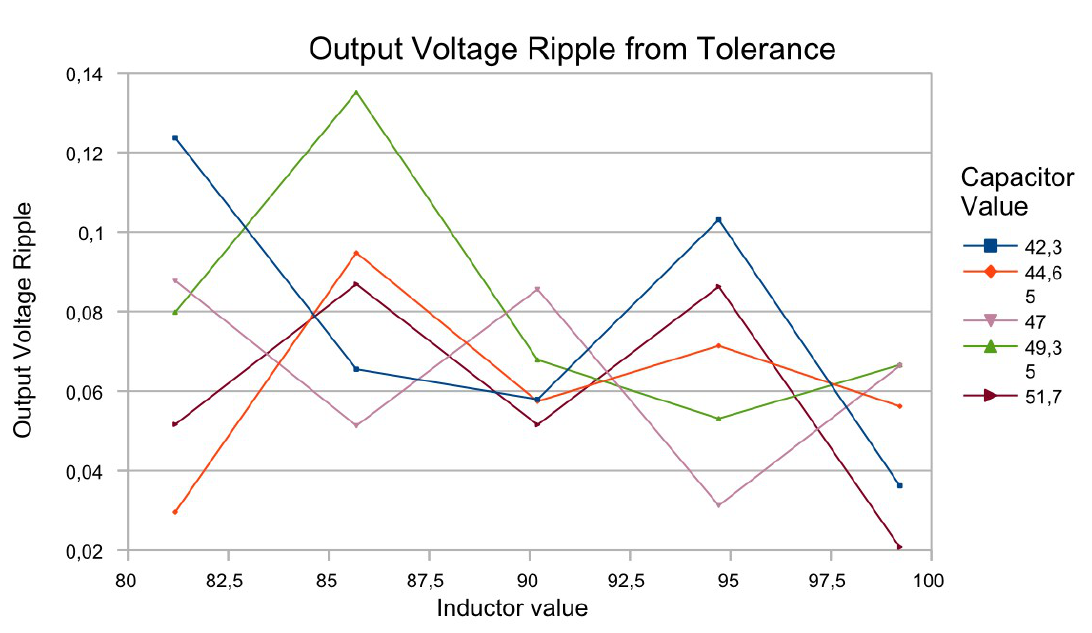
Figure 12. Tolerance analysis of the average output voltage with optimized values.